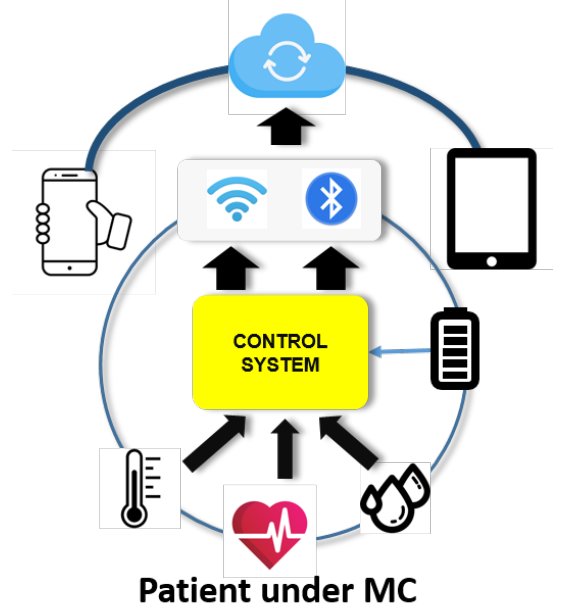
Figure 2. Block diagram for the proposed system: the patient’s sensor data are uploaded to the cloud continuously.